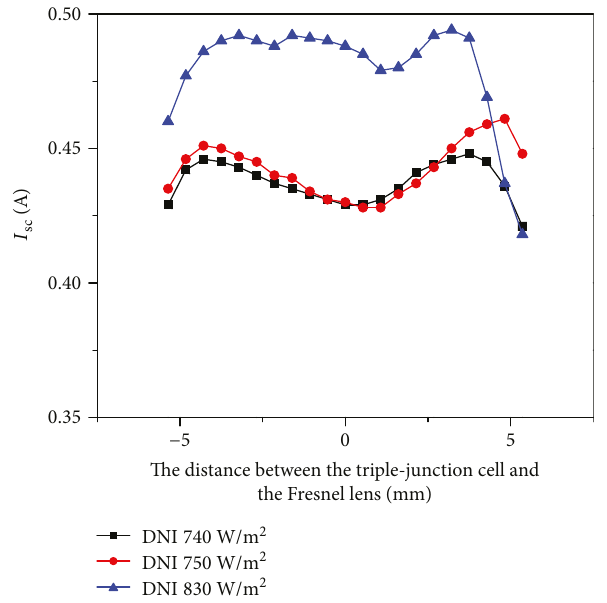
Figure 14: Changes in the fi ll factor of the triple-junction cell with the position of the optical